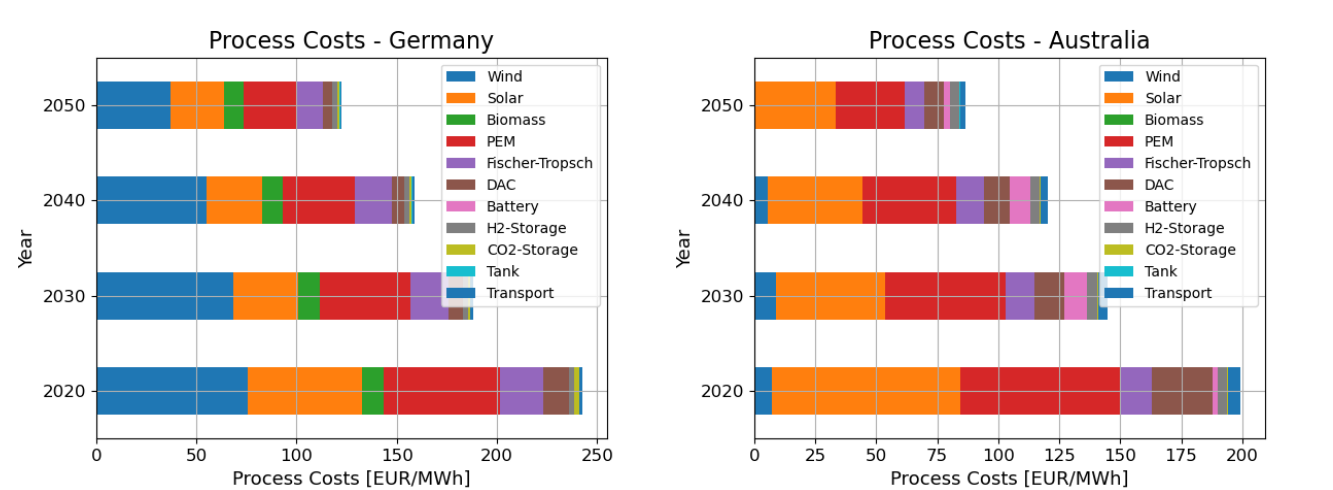
Figure 8. Process costs’ development and